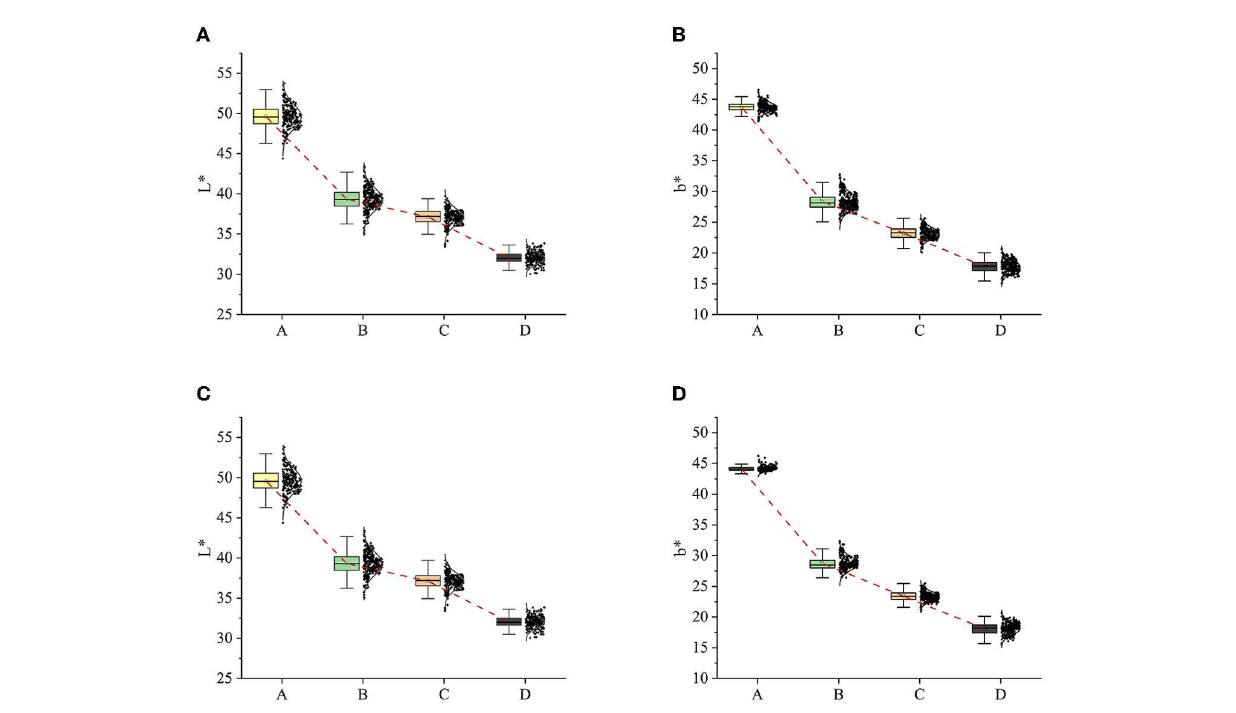
FIGURE10 L-values and b-values distribution of images after aggregation. (A) L-values distribution after AL*. (B) b-values distribution after Ab*. (C) L-values distribution after AL*b*. (D) b-values distribution after AL*b*.